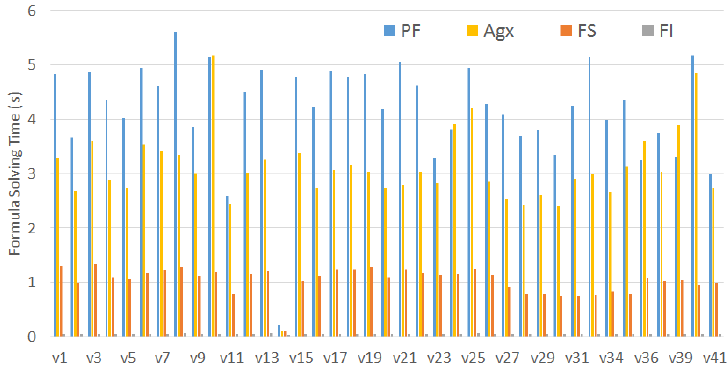
Figure 8. Formula solving time of different methods on the TCAS